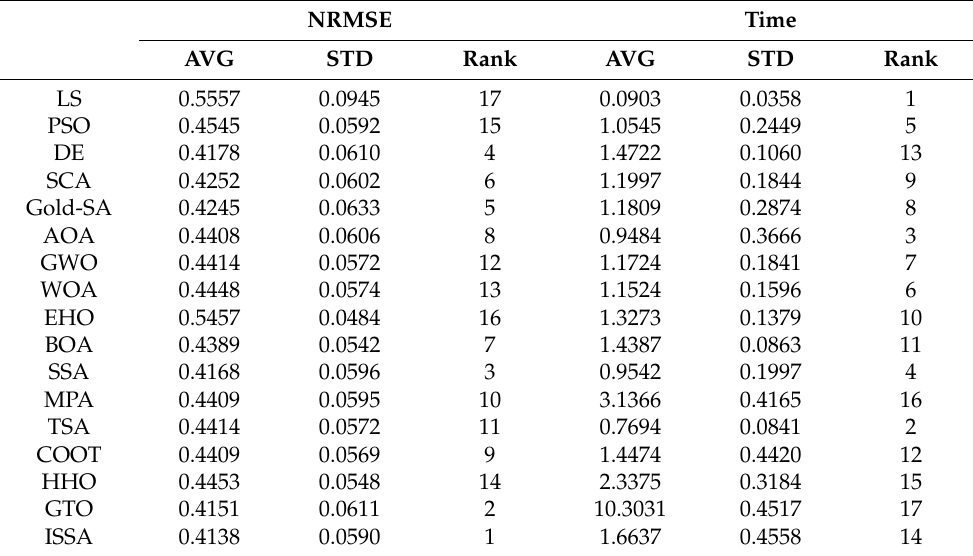
Table 4. Positioning results of 17